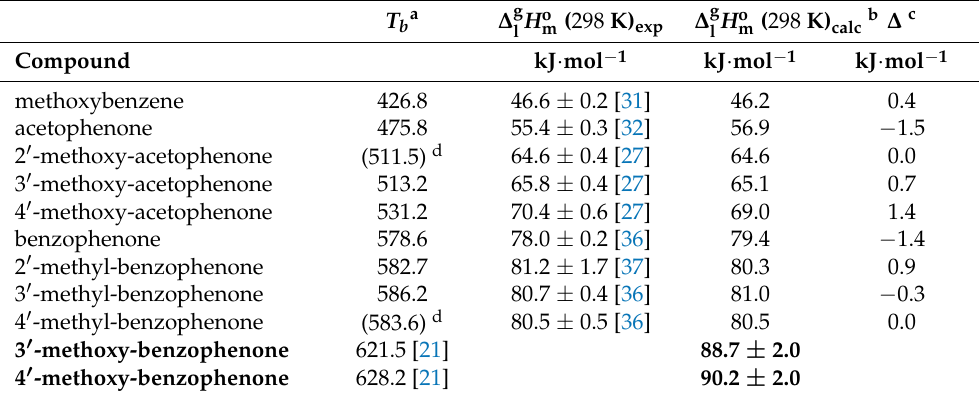
Table 6. Correlation of vaporisation enthalpies, ∆ g derivatives with their normal boiling temperatures ( T b